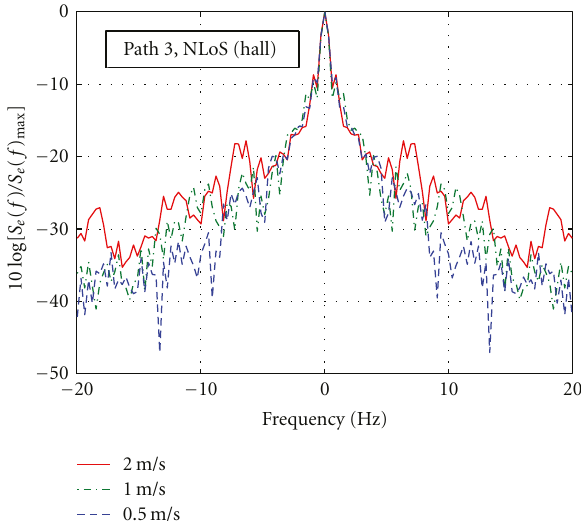
Figure 10: Power spectral density for the firefighter at varying speeds along path 2 (sideways, NLoS). The power densities of the four antennas are summed in the frequency domain.